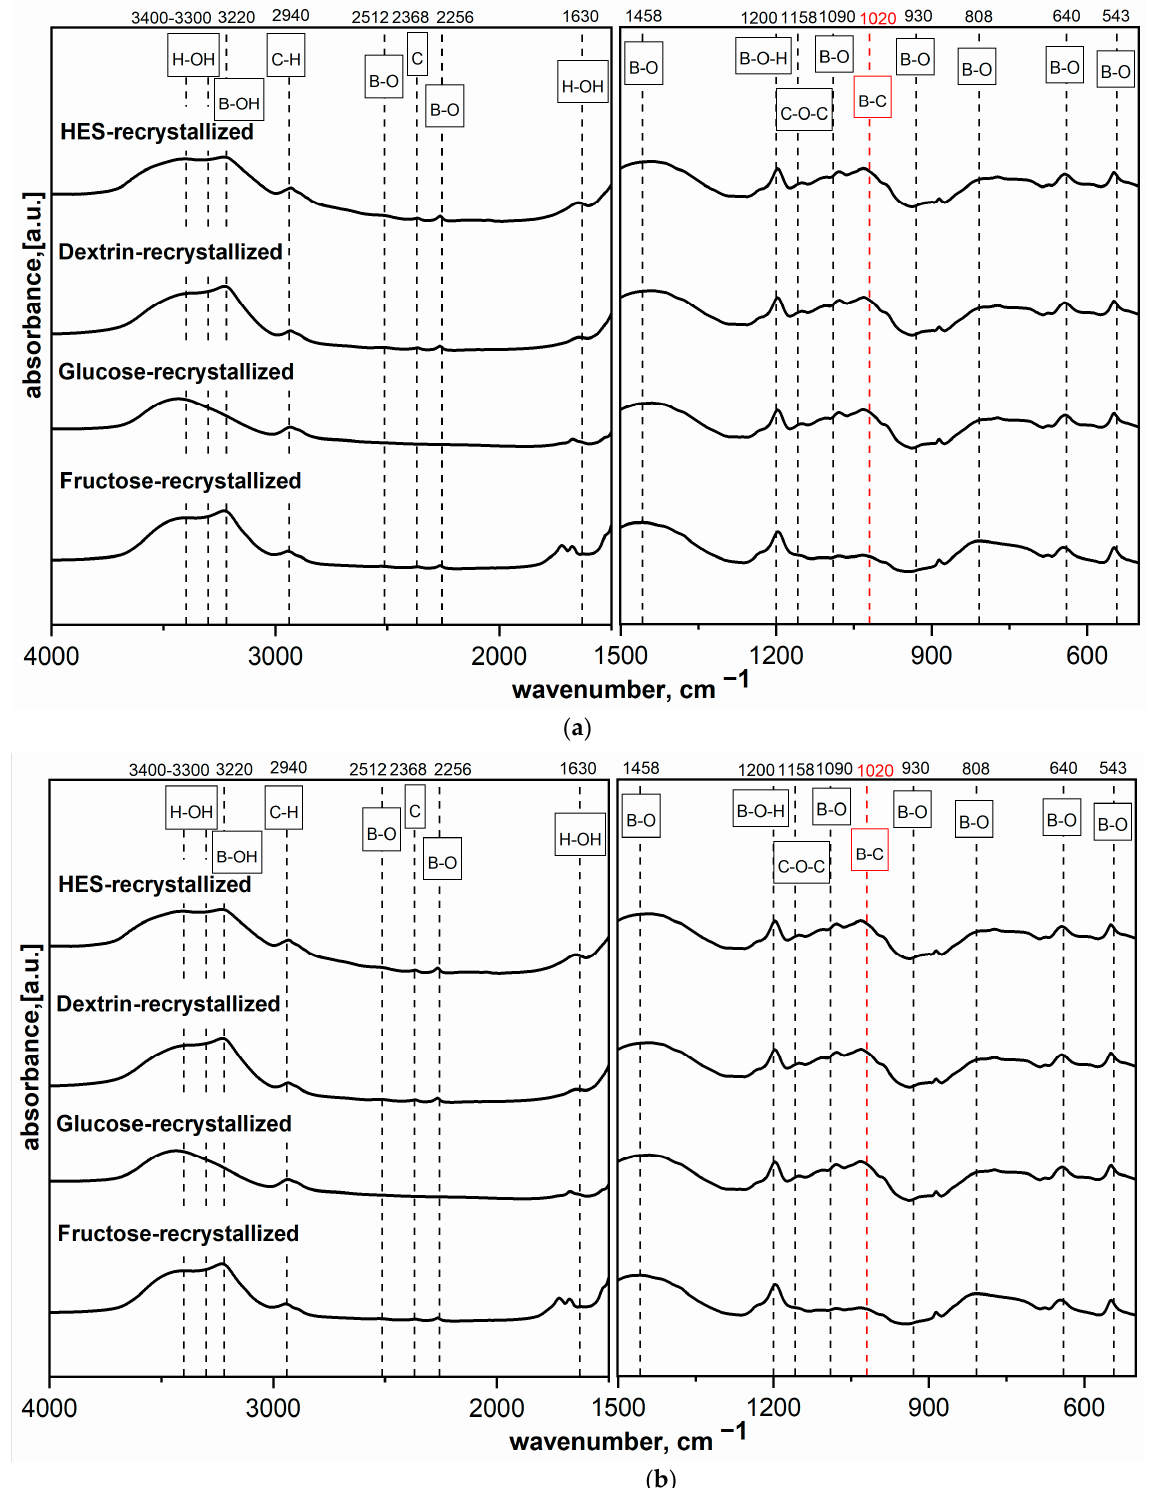
Figure 2. MIR spectra of the different saccharide precursors mixed with boric acid with a molar ratio of boron to carbon of 1:9: ( a ) dried at 90 °C and ( b ) freeze-dried.